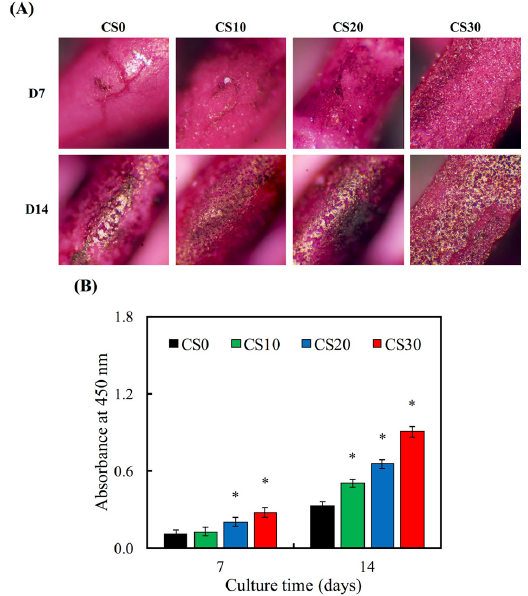
Figure 11. ( A ) Alizarin red S staining and ( B ) quantification of calcium mineral deposits by hMSCs cultured on Mg–CS/PCL for 1 and 2 weeks. The “*” indicates a significant difference ( p < 0.05) compared to CS0.